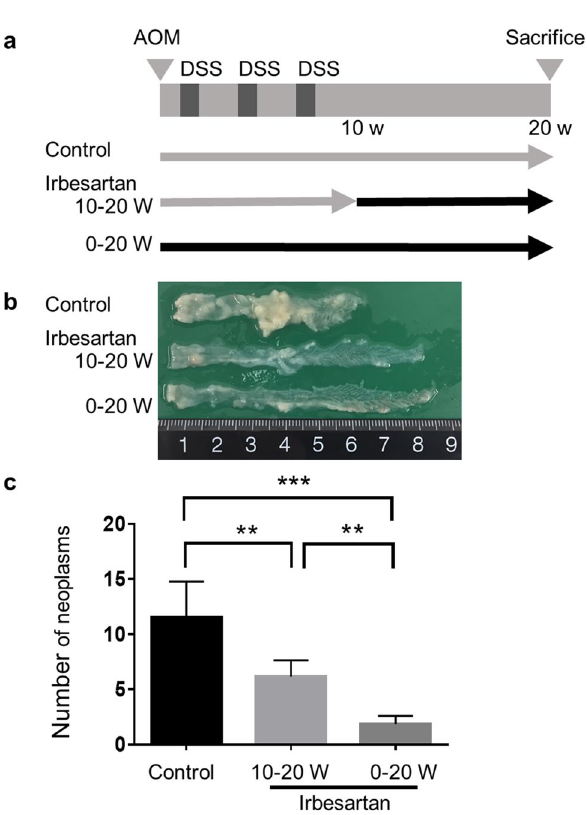
Figure 6. Effect of irbesartan on colitis-associated colon tumour progression. ( a ) Treatment scheme of the azoxymethane/dextran sodium sulphate (AOM/DSS) model. ( b) Macroscopic view of the colon lumen. Tumours developed in the distal to middle colon of control mice, irbesartan-treated mice for 10–20 weeks and irbesartan-treated mice for 0–20 weeks. Colons were removed 20 weeks after AOM initial administration. ( c ) The histograms show the number of neoplasms. Results are from one experiment with six mice per group. The experiments were performed three times and yielded similar results. Data are presented as mean ± SD. **P < 0.01 and ***P <